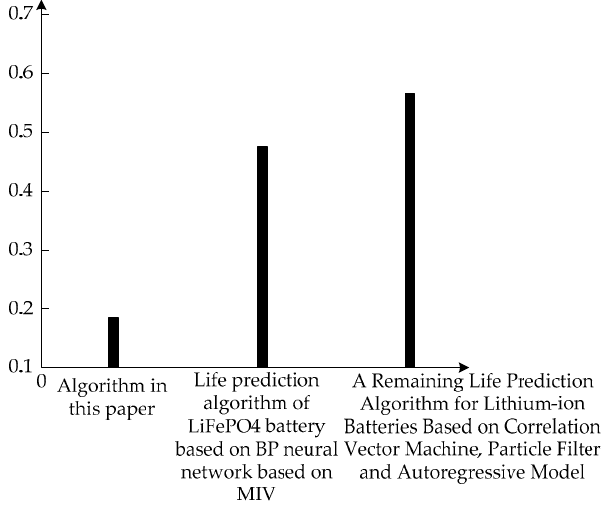
Figure 8. The average error values of the different algorithms.